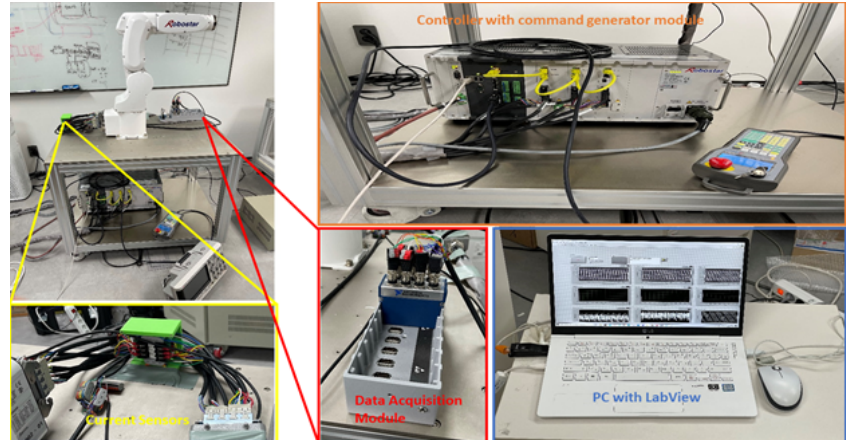
Figure 10. Data Acquisition system for